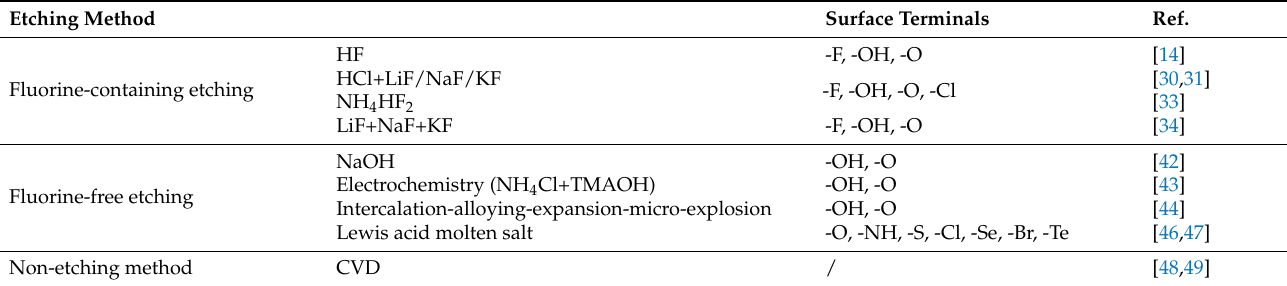
Table 1. Summary of etching